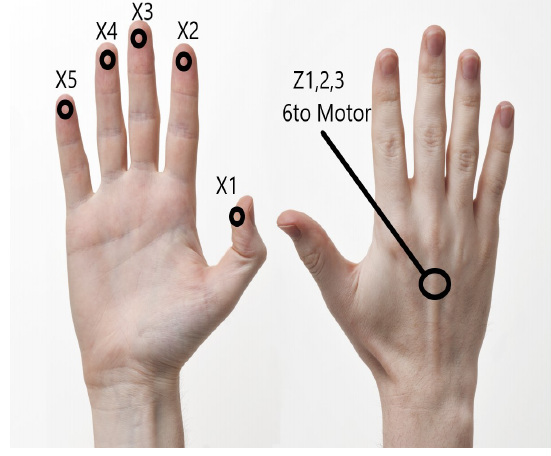
Figure 4. Distribution of haptic motors in the hand.